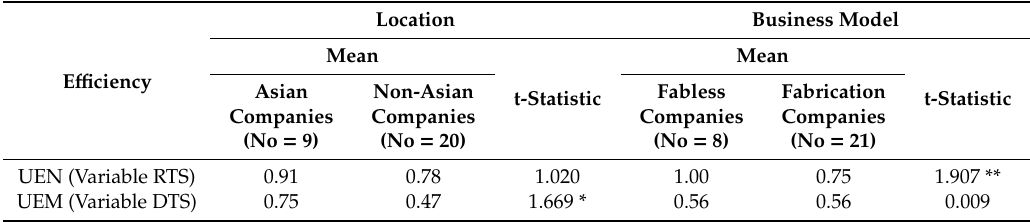
Table 8. Summary of mean